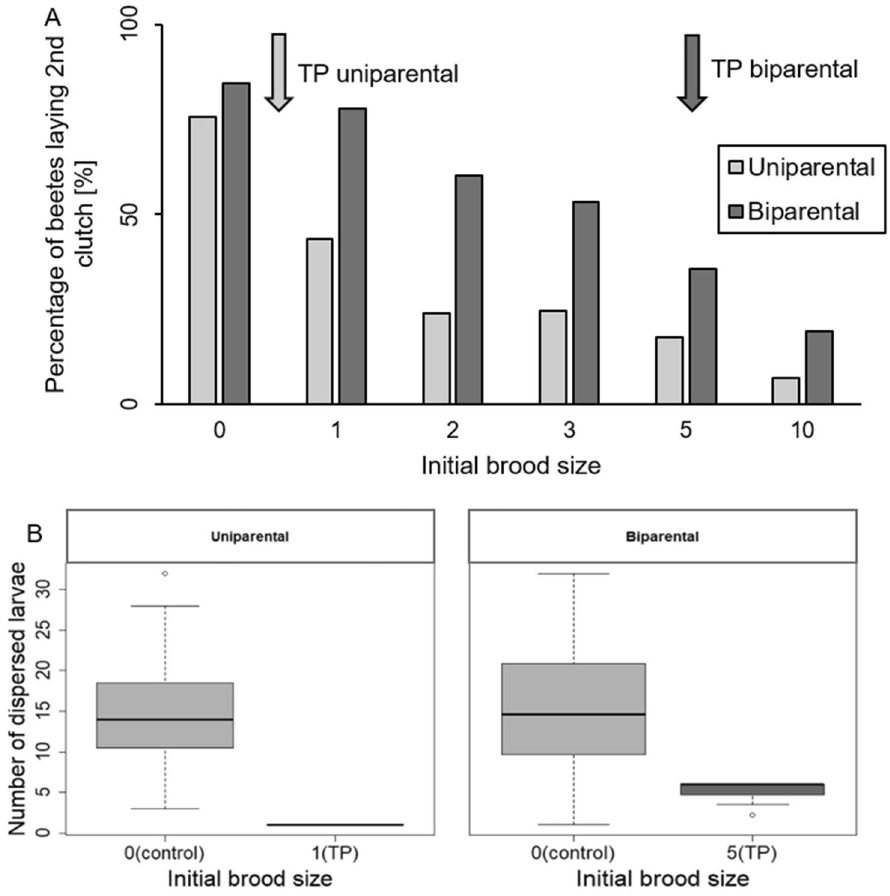
Figure 4. ( A ) Bar plot showing the tipping points of females in uniparental (gray) and biparental condition (dark grey). Arrows in respective colors mark the tipping points (= TPs), i.e., the initial brood size at which less than 50% of females resumed egg laying. Note that at both tipping points, the proportion of females that did not produce a second clutch was significantly smaller than in the respective control groups (i.e. the treatment in which brood size was zero and females did not receive any larvae; uniparental females: Chi 2 = 9.70, p = 0.002, biparental females: Chi 2 = 22.41, p < 0.001). ( B ) Boxplots showing number of dispersed larvae of females of the control groups and females that did not produce a second clutch at the respective tipping points.